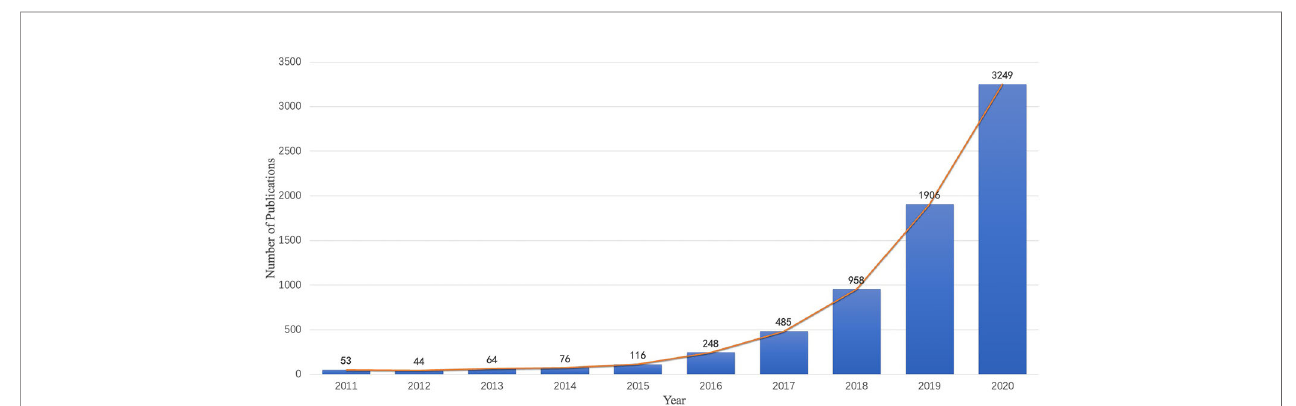
FIGURE 1 | Work fl ows of this study.